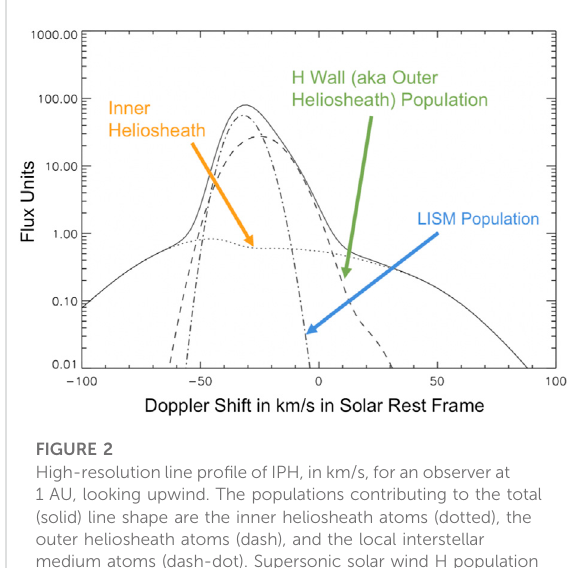
FIGURE 2 High-resolution line pro fi le of IPH, in km/s, for an observer at 1 AU, looking upwind. The populations contributing to the total (solid) line shape are the inner heliosheath atoms (dotted), the outer heliosheath atoms (dash), and the local interstellar medium atoms (dash-dot). Supersonic solar wind H population moves at ~400 km/s and is not observable with UV spectroscopy as they are Doppler-shifted beyond the width of solar illuminating fl ux. Figure adapted from Quémerais and Izmodenov